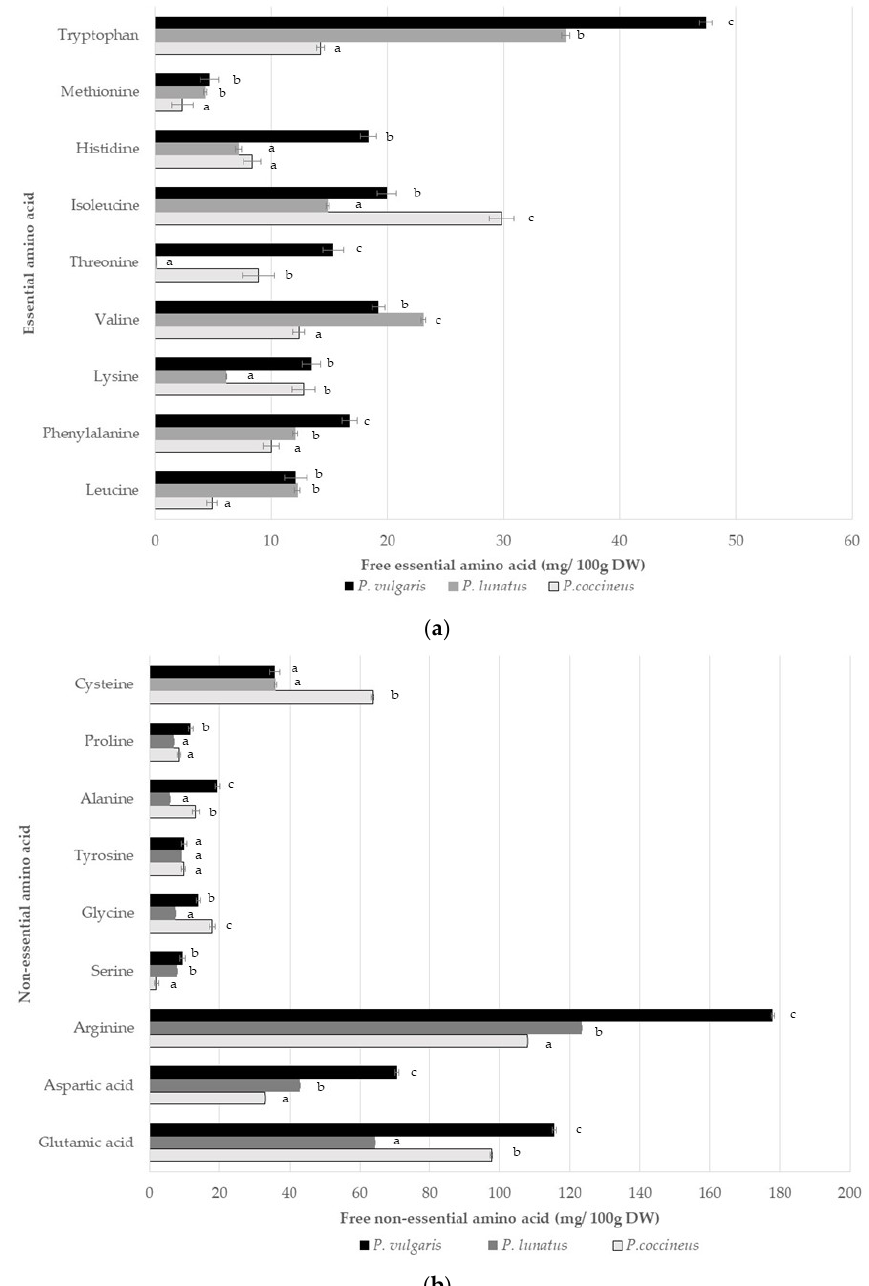
Figure 2. Free amino acids ( a ) essential and ( b ) non-essential. Mean values ± SD with different lowercase letters within the same sub-figure denote significant differences based on Tukey’s test ( p < 0.05). DW: dry weight.